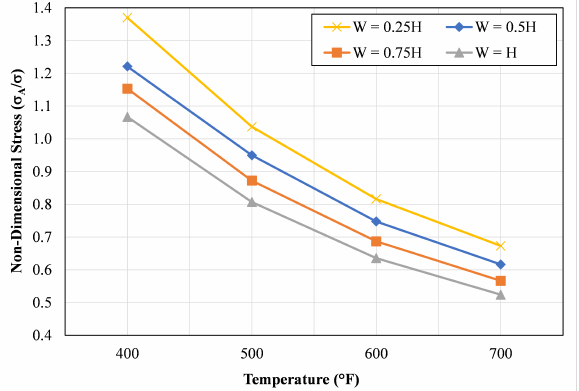
Figure 7: Relationship between σ A / σ of the 16-inch diameter expan- sion loops pipe with increasing temperature.